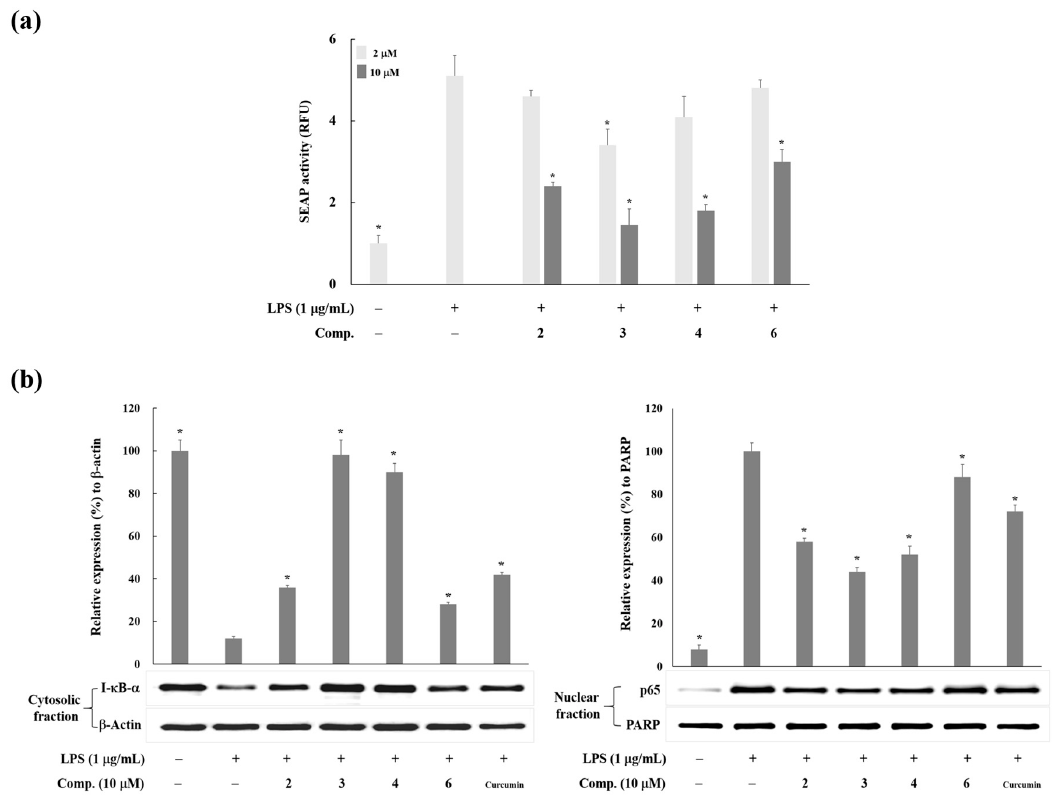
Figure 3. The inhibitory effects of Compounds 2 – 4 and 6 from B. kazinoki on LPS-induced NF- κ B activity and nuclear accumulation. ( a ) Effect of Compounds 2 – 4 and 6 on LPS-induced NF- κ B transcriptional activation in stably transfected RAW 264.7 cells with pNF- κ B-SEAP-NPT (T-RAW 264.7 cells). Cells were pretreated with Compounds 2 – 4 and 6 for 30 min prior to LPS treatment (1 µ g/mL) for 6 h. Aliquots of culture medium were analyzed for the measurement of secretory alkaline phosphatase (SEAP) activity. The values present as means ± S.D. of three independent experiments. * p < 0.05; ( b ) The effect of Compounds 2 – 4 and 6 on the degradation of I- κ B- α and the accumulation of p65 in nuclei in LPS-stimulated macrophages. RAW 264.7 cells were pretreated with compounds for 30 min prior to LPS treatment (1 µ g/mL) for 15 min. Cytosolic and nuclear extracts were prepared for the Western blotting of I- κ B- α and p65, respectively. The relative intensities of I- κ B- α to β -actin and p65 to PARP bands were measured by densitometry. The values express the means ± S.D. of three experiments. * p < 0.05. Curcumin was used as the positive control. Images are the representative of three independent experiments with similar results.